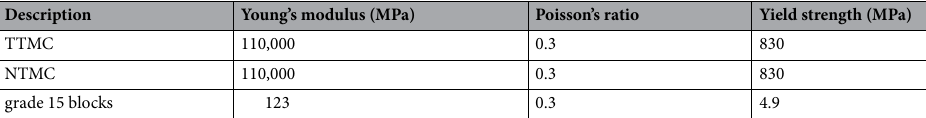
Table 1. Material properties of the components of the finite element (FE) model. NTMC novel titanium mesh cage, TTMC traditional titanium mesh cage.